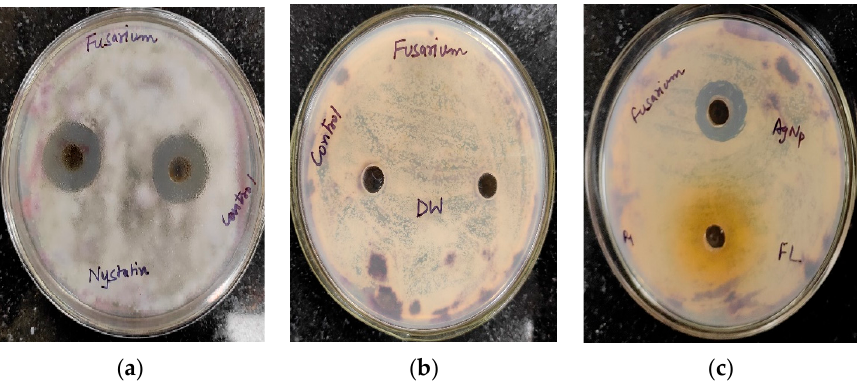
Figure 11. Antifungal activity against Fusarium oxysporum : ( a ) positive control (Nystatin) ( b ) negative control (distilled water (DW)); ( c ) AgNPs and leaf extract (FL).